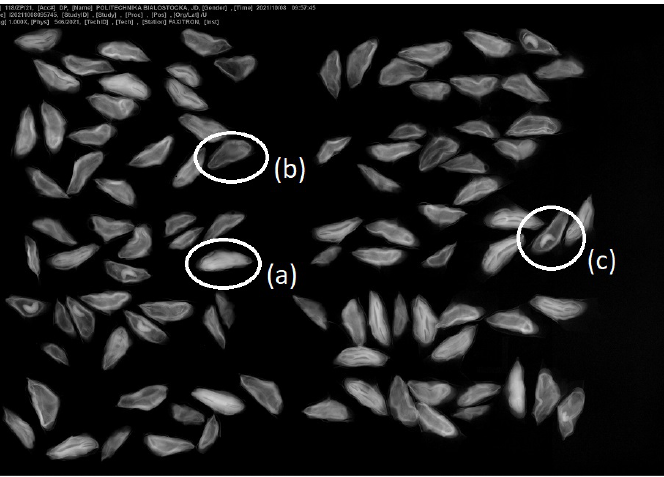
Figure 4. X-ray pictures of silver fir seeds with the examples marked ( a ) correctly shaped, ( b ) empty, ( c ) insect larva (photo D. Polatowska, The Kostrzyca Forest Gene